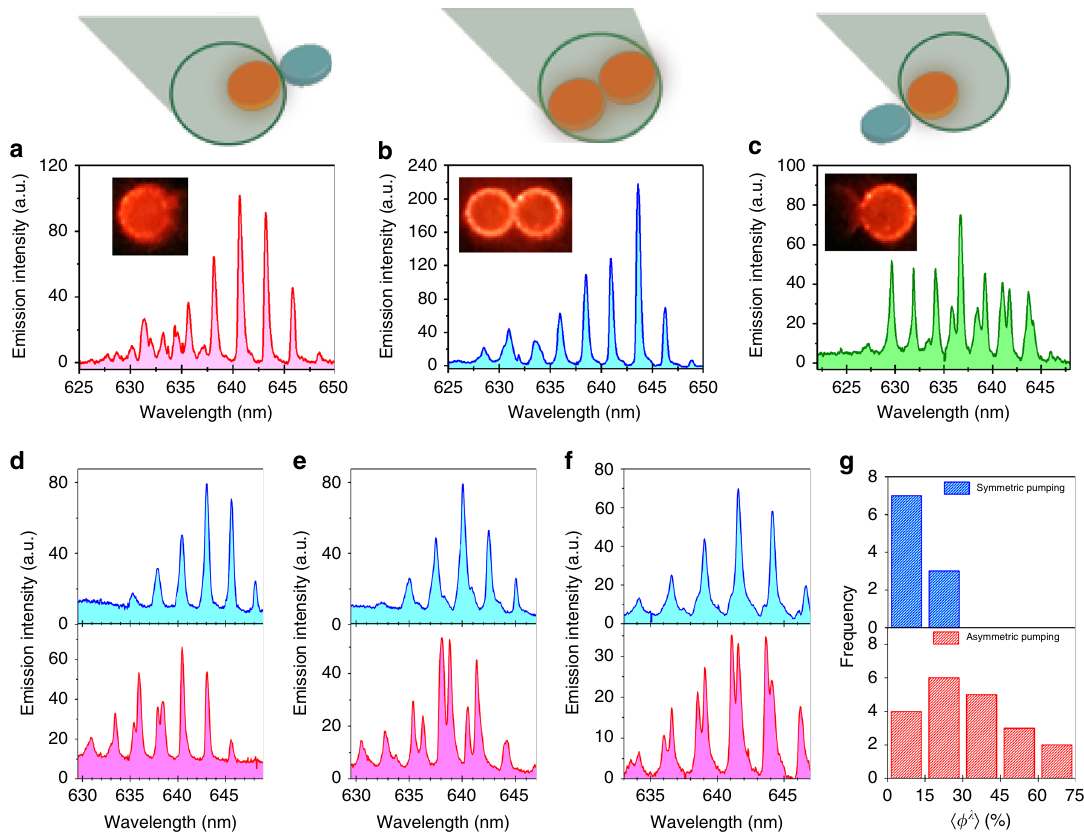
Fig. 2 Emission characteristics of coupled pairs of microdisk resonators. a – c Laser emission spectra from a coupled microdisk pair, where the pair is placed at different locations in the pump beam spot, such that only the left or right microdisk is pumped ( a and c ), or the pair is pumped evenly, ( b ), as illustrated schematically above each plot. The insets show the fl uorescent image from the microdisks in each case. d – f Laser emission spectra from three different microdisk pairs pumped at 116 μ J/cm 2 . In each fi gure the spectrum from the evenly-pumped pair (blue) is compared to a spectrum from the asymmetric pumping scheme (red). The evenly-pumped pair consistently shows a reduction in mode-splitting compared to the asymmetric case. g Frequency (cid:1) (cid:3) distribution of the spectrally averaged modal splitting parameter, ϕ λ , (de fi ned in Eq. 1) for the symmetric (blue) and asymmetric pumping schemes